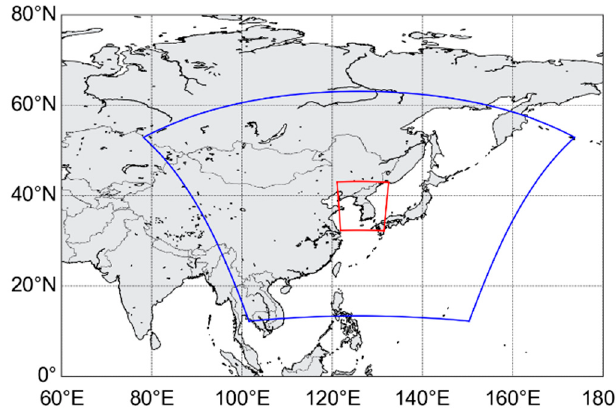
Figure 5. Domain of the UM system, where Regional Data Assimilation and Prediction System (RDAPS) and Local Data Assimilation and Prediction System (LDAPS) are denoted by blue and red lines [23].